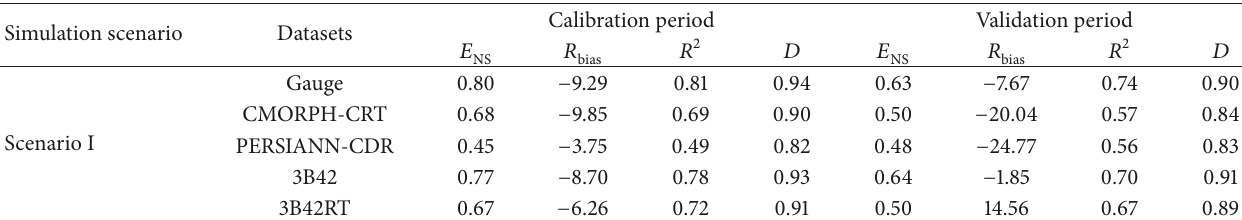
Table 4: Skill indices of HEC-HMS simulations for the calibration and validation periods under scenario I. Simulation scenario